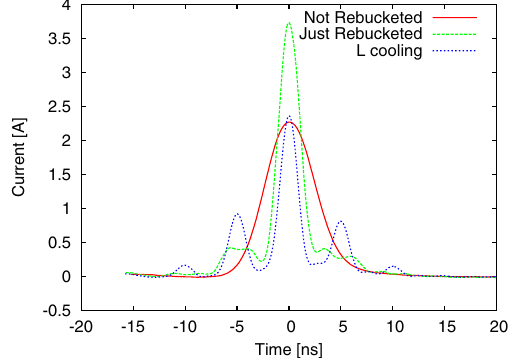
FIG. 4. Measured longitudinal bunch profiles for a same fill: without rebucketing (red), shortly after rebucketing (green), and with longitudinal cooling for 2 hours at store